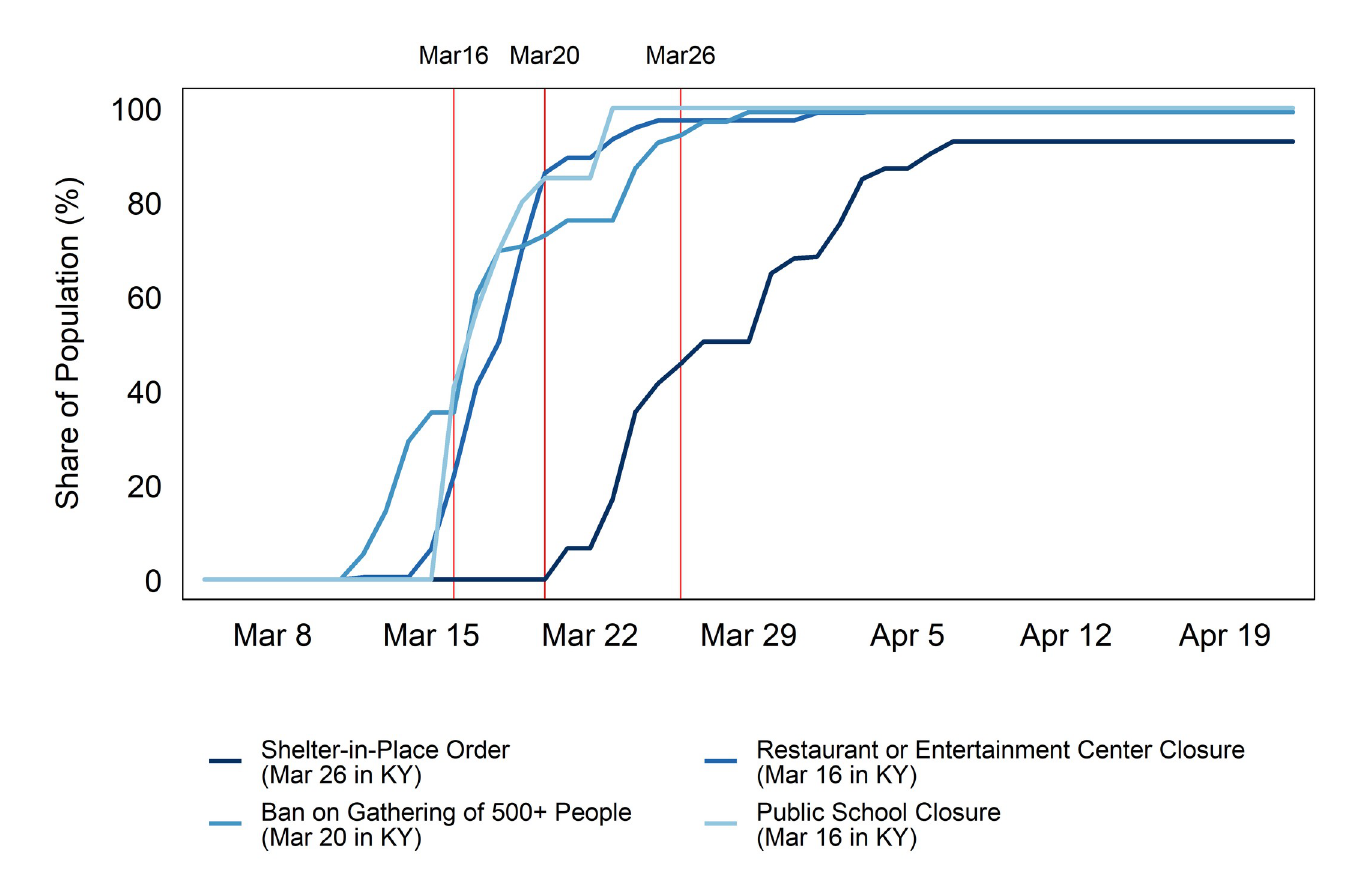
Fig 1. Fraction of population in Southern and Midwestern states covered by social-distancing measures. Notes: Authors’ calculations from population-weighted county data. The red lines indicate Kentucky’s adoption dates.